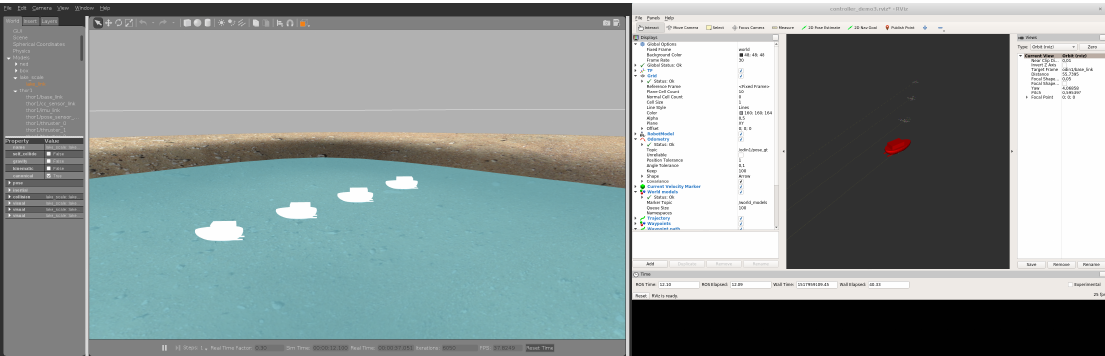
Figure 11. Gazebo on the left and Rviz Editor with an Rviz configuration file to the namespace odin1 on the right.